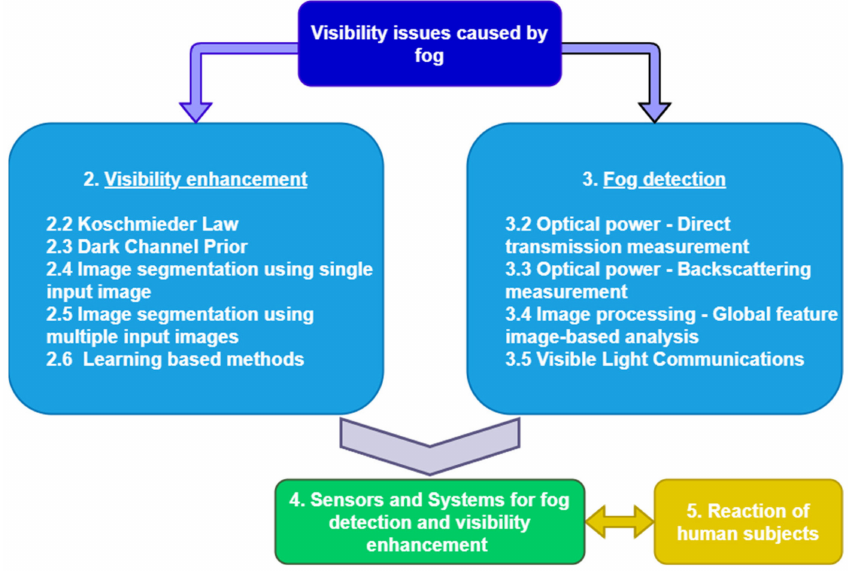
Figure 1. Overall